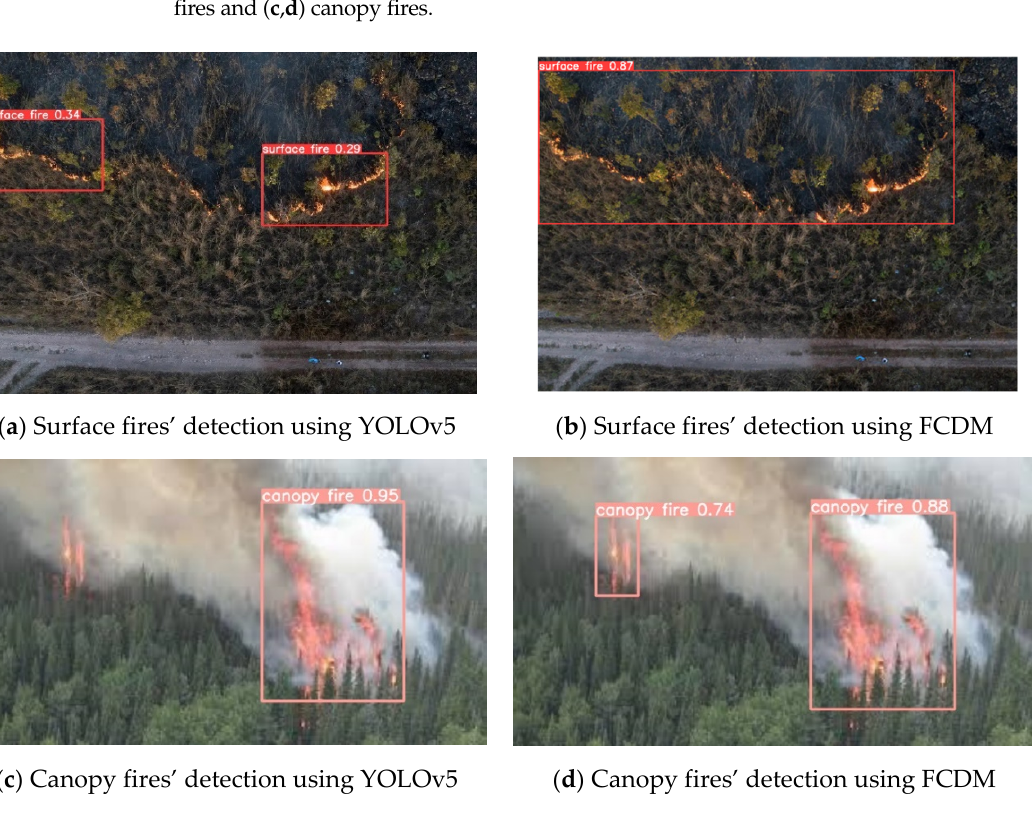
Figure 11. The detection effect of YOLOv5 and FCDM model for typical forest fire images. ( a , b ) Surface fires and ( c , d ) canopy fires.